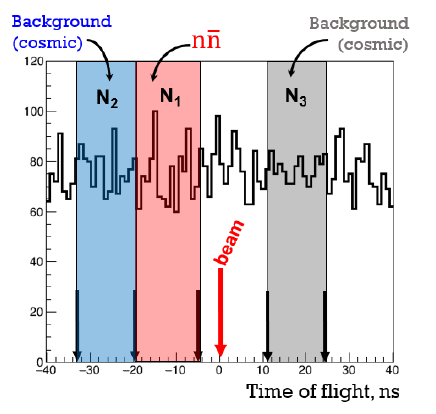
Figure 3: MLP output for n ¯ n events. Figure 4: Counting signal events. N(signal) = N 1 – N 3 and N(control) = N 2 – N 3 . Borders depend from the E beam